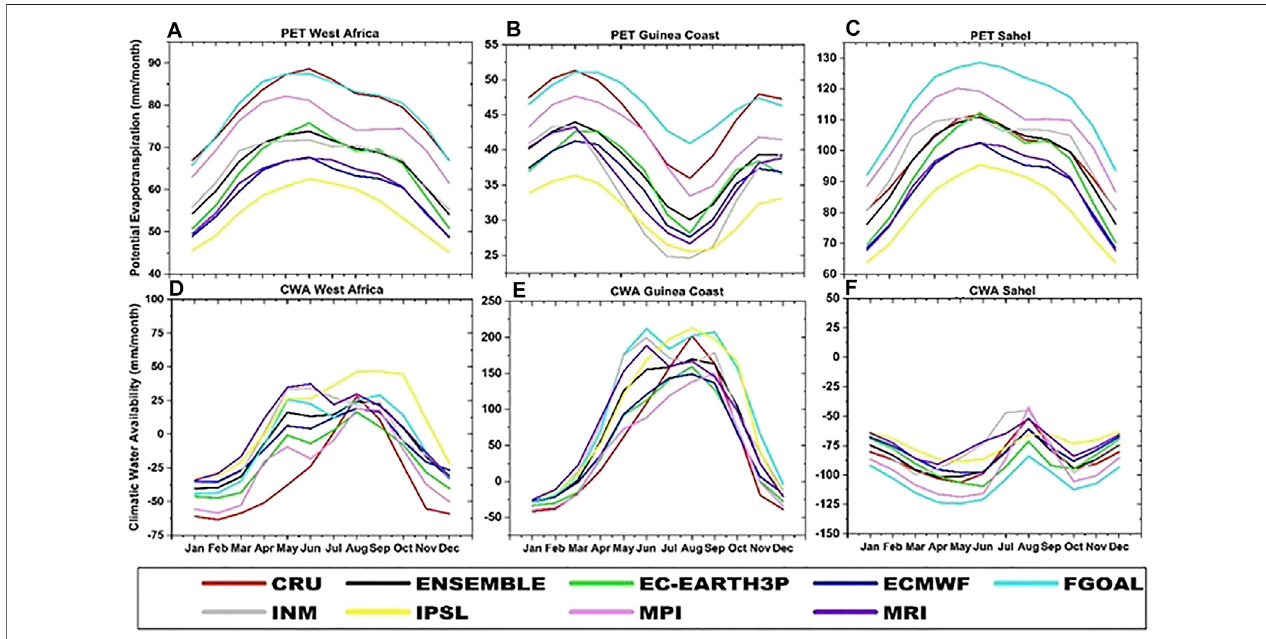
FIGURE 2 | Annual cycle of potential evapotranspiration (PET) and climatic water availability (CWA) over West Africa, Guinea Coast, and the Sahel during the historical period 1985 – 2014 with respect to CRU. A – C and C – F represents PET and CWA respectively, over West Africa, Guinea Coast and Sahel.